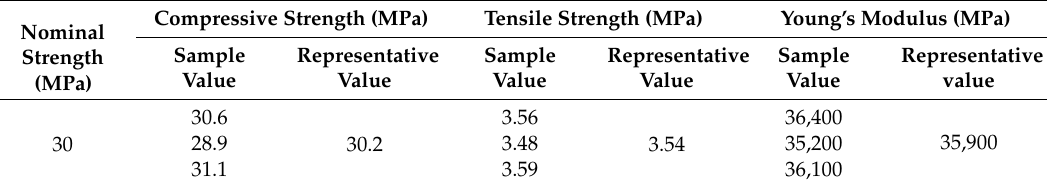
Table 2. Material properties of the Table 2 . Material properties of the concrete .